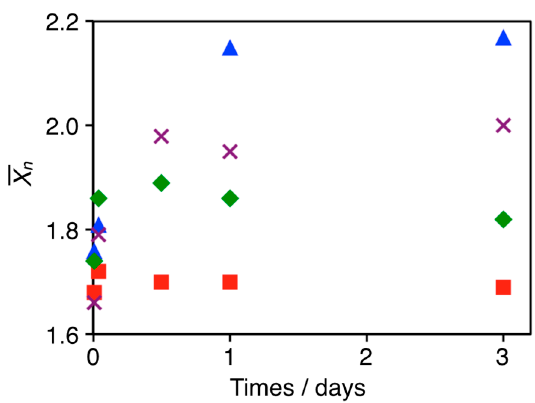
Figure 6. Average number of cAuNPs in each assembly ( X n ) vs time. cAuNP14–DPPC composite solutions were cooled in an ice bath after heating at 50 ◦ C for 10 min (red squares), 1 h (blue rhombuses), and 12 h (purple crosses). Blue triangles are X n for cAuNP 14 –DPPC composites heated for 3 days without cooling.